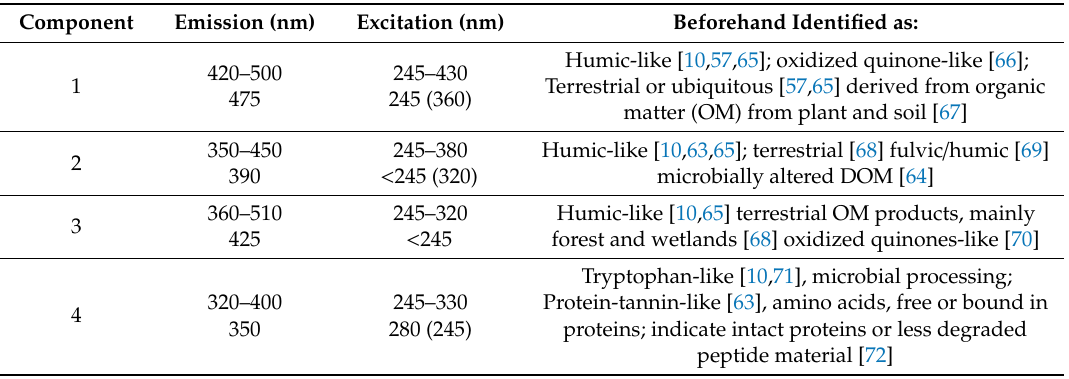
Table 2. Four components (C1–4) are identified by parallel factor analysis (PARAFAC) modeling. Range and maximum of emission and excitation wavelengths (nm) are given; Secondary peaks are displayed in brackets; including previous identification by literature.